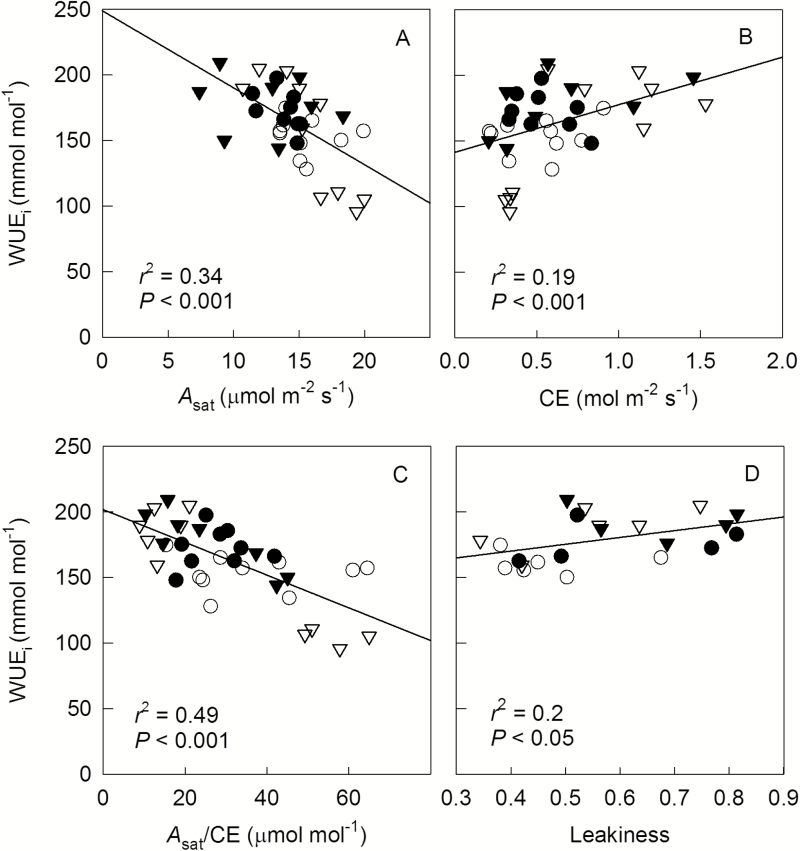
Correlations between WUEi and Asat (A), CE (B), Asat/CE (C), and leakiness (D) of leaves grown at low or high N fertilizer supply (N1, circles; or N2, triangles) combined with low or high VPD (V1, open symbols; or V2, filled symbols). Each symbol represents a data point of an individual plant.